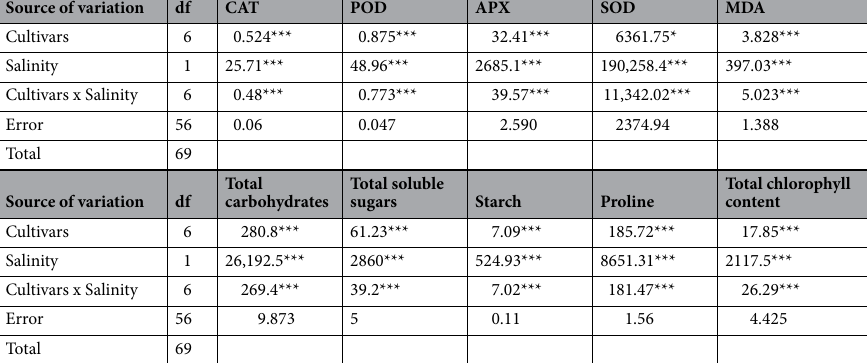
Table 2. Mean squares from ANOVA of the data for concentration of anti-oxidant enzymes, MDA, organic osmolytes and total chlorophyll content of seven selected wheat cultivars subjected to 150 mM NaCl salinity. df degree of freedom, CAT catalase, POD peroxidase, APX ascorbate peroxidase, SOD superoxide dismutase, MDA Malondialdehyde. *, **, *** significant at 0.05, 0.01, and 0.001